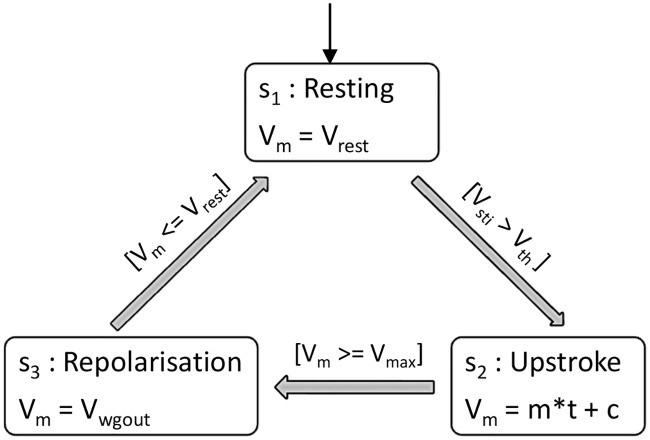
State controller of Resonant model for ventricular myocyte.Vm = membrane potential, Vrest = resting membrane potential, Vsti = voltage stimulus to a cell, Vth = threshold membrane potential, Vmax = maximum membrane potential, and Vwgout = membrane potential from waveshape generator.